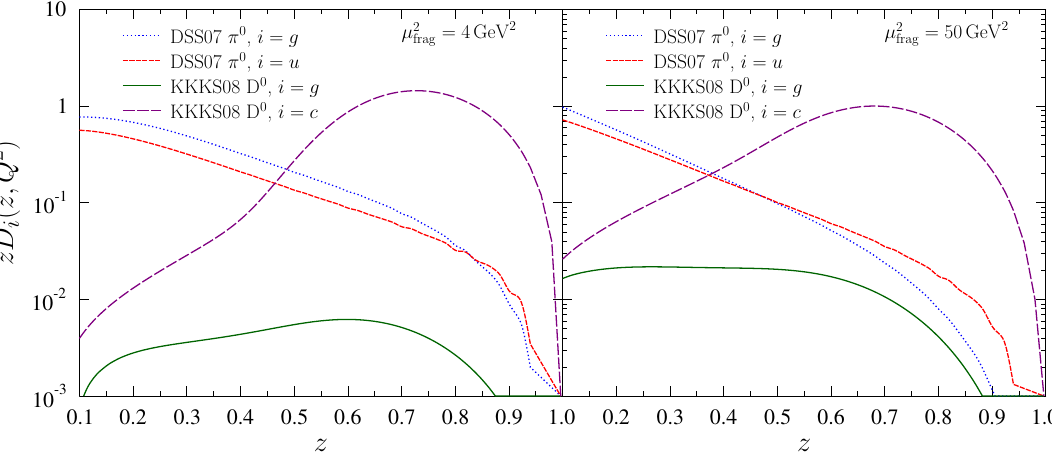
Figure 5 . Left-hand panel: a comparison between (cid:25) 0 FFs from the DSS07 analysis [69] and D 0 FFs from the KKKS08 (cid:12)t [61] at (cid:22) 2 = 4 GeV 2 . Right-hand panel: as the left-hand panel but at frag (cid:22) 2 = 50 GeV 2 frag